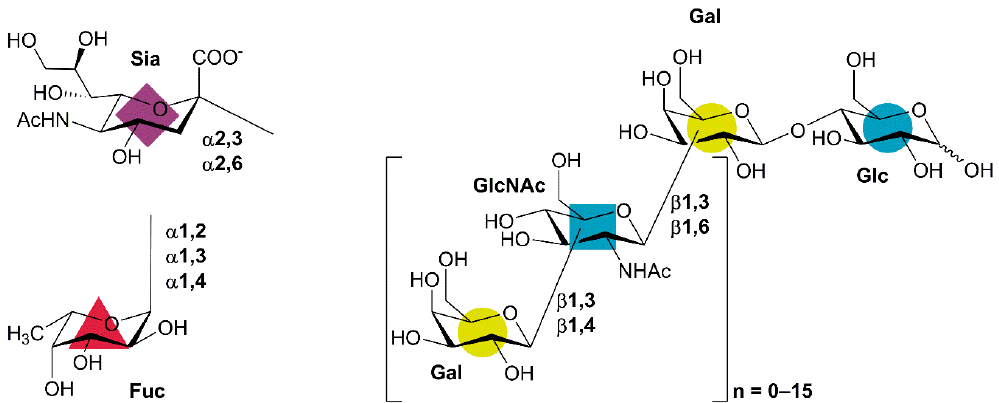
Figure 1. Human milk oligosaccharide (HMO) blueprint structure [1]. Gal: galactose, Glc: glucose, Figure1. Humanmilkoligosaccharide(HMO)blueprintstructure[1]. Gal: galactose,Glc: glucose,GlcNAc: GlcNAc: N- acetylglucosamine, Fuc: fucose, Sia: sialic acid ( N- acetylneuraminic acid). Lactose is at the N -acetylglucosamine, Fuc: fucose, Sia: sialic acid ( N -acetylneuraminic acid). Lactose is at the reducing end reducing end of all HMO structures, which may be elongated with β - N -acetyllactosamine (LacNAc) ofallHMOstructures,whichmaybeelongatedwith β - N -acetyllactosamine(LacNAc)orlacto- N -bioseunits. or lacto- N -biose units. Both lactose and elongated structures may be decorated with Fuc and/or Sia. Both lactose and elongated structures may be decorated with Fuc and / or Sia. The colored shapes indicate The colored shapes indicate the Symbol Nomenclature for Glycans (SNFG [8], the Symbol Nomenclature for Glycans (SNFG [8], https: // www.ncbi.nlm.nih.gov / glycans / snfg.html), https://www.ncbi.nlm.nih.gov/glycans/snfg.html), which is commonly used for presenting the numerous HMO structures.